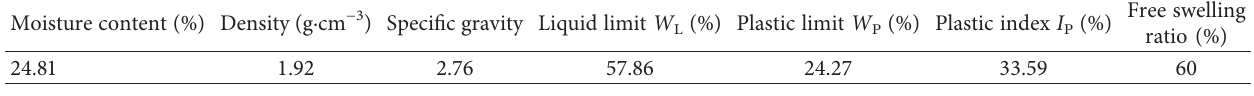
Table 1: Physical property of red clay samples.